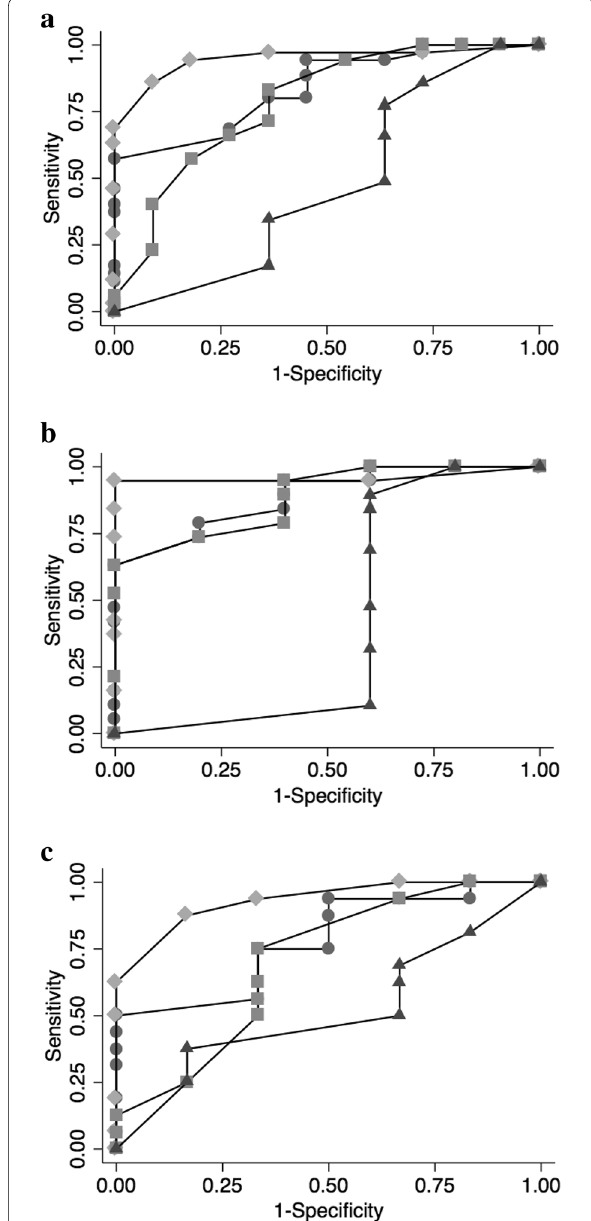
Fig. 4 Combined Receiver Operating Characteristic (ROC) curves of overall (panel A), training set (panel B) and validation set (panel C) for total (circles) and regional ventral (rhombus), intermediate (squares) and dorsal (triangles) LUS score in identifying non-focal ARDS morphologies. AUC ROC (95% CI) of LUS V for non-focal ARDS was 0.948 (0.888–1.000), 0.958 (0.881–1.000) and 0.932 (0.832–1.000) in overall, training set and validation set,